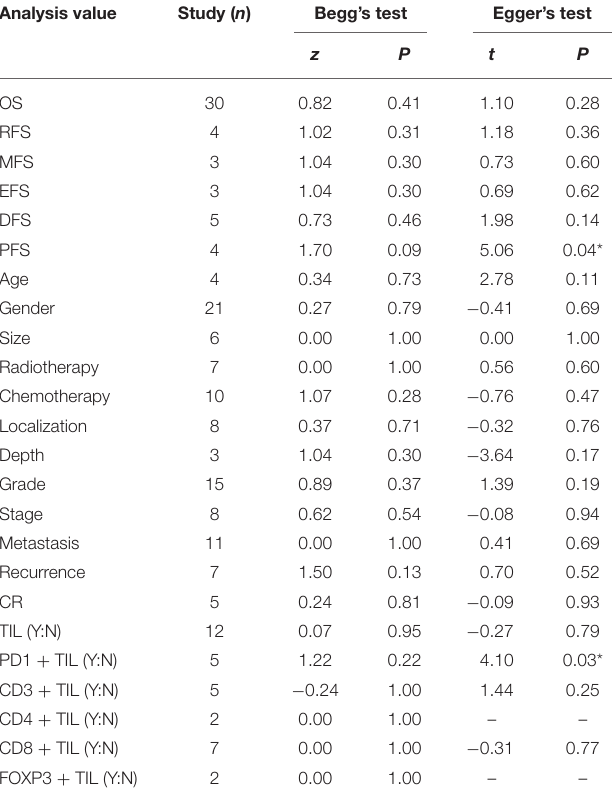
TABLE 4 | Begg’s test and Egger’s test for publication bias. Analysis